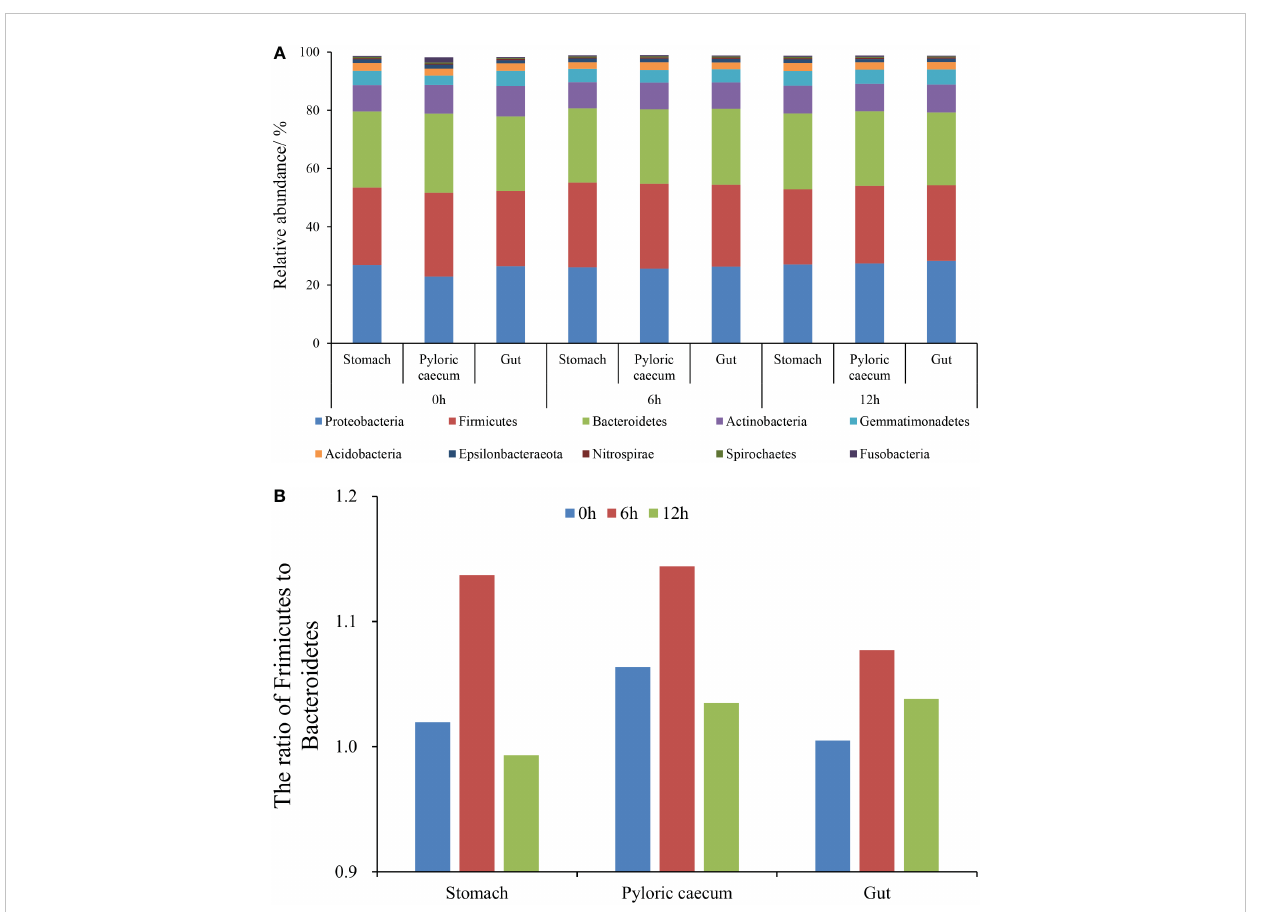
FIGURE 3 The structural characteristics of gastrointestinal microbiota at the phylum level. (A) The top-ten phyla with relative abundance; (B) The ratio of Firmicutes to